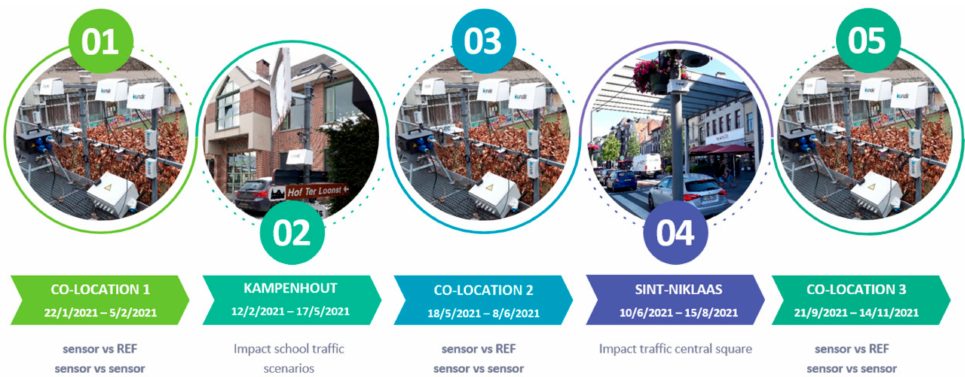
Figure 1. Timing of subsequent benchmarking (co-location) and pilot (Kampenhout and Sint-Niklaas) campaigns during our study. Each co-location campaign evaluated the comparability between the sensors and equivalent measurements (sensor vs. REF) and intra-sensor comparability (sensor vs.